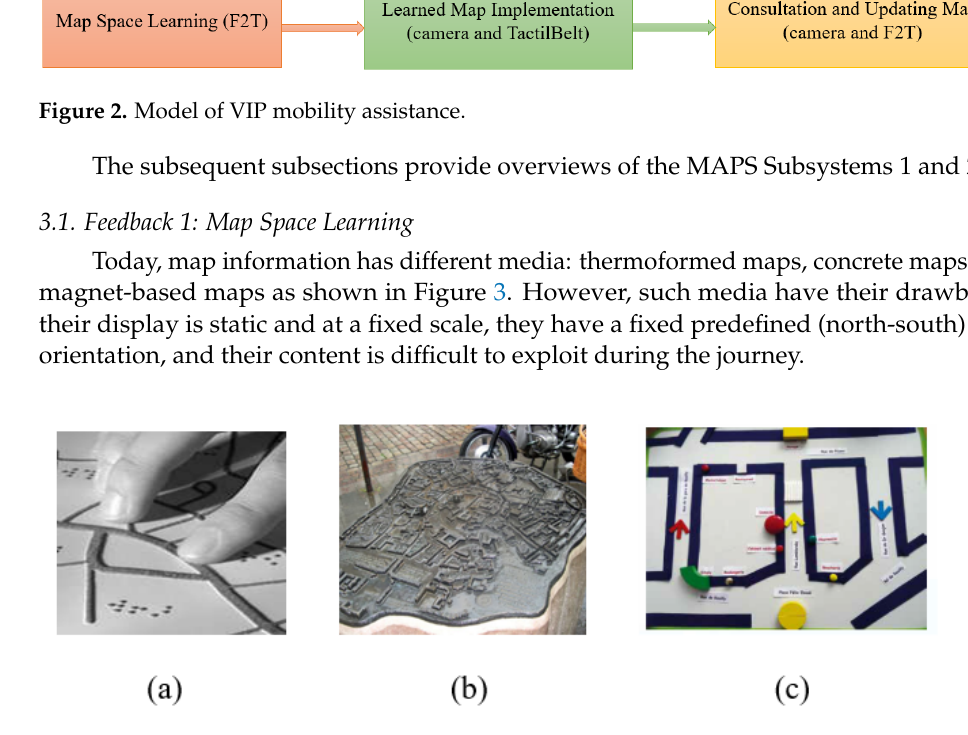
Figure 3. Map learning: ( a ) thermoformed map; ( b ) concrete map; ( c ) magnet-based map.